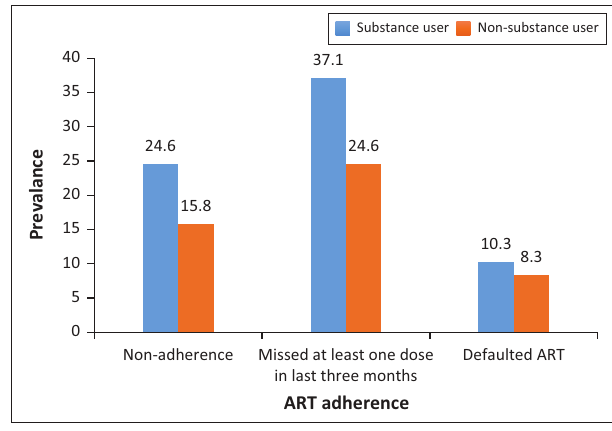
FIGURE 2: Non-adherence of antiretroviral treatment and default rate after 6-month follow-up.